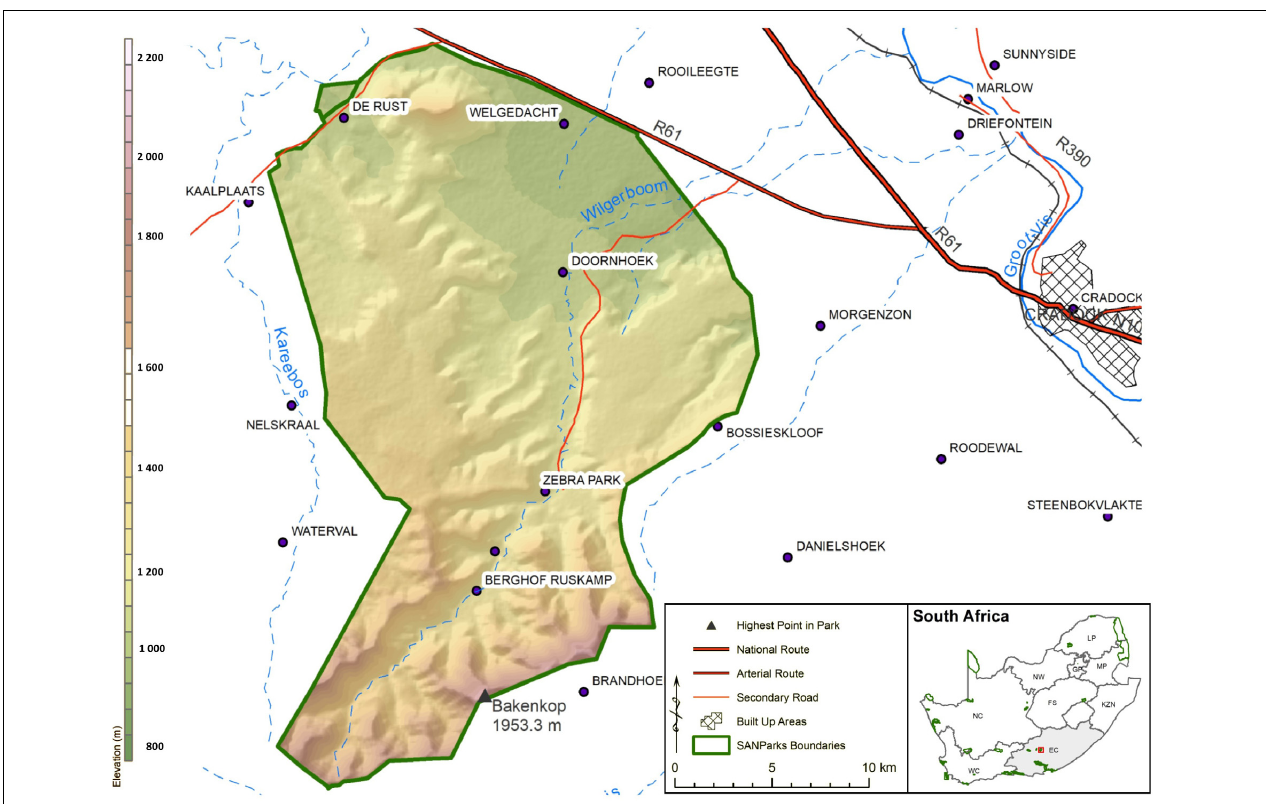
FIGURE 1 | Location of Mountain Zebra National